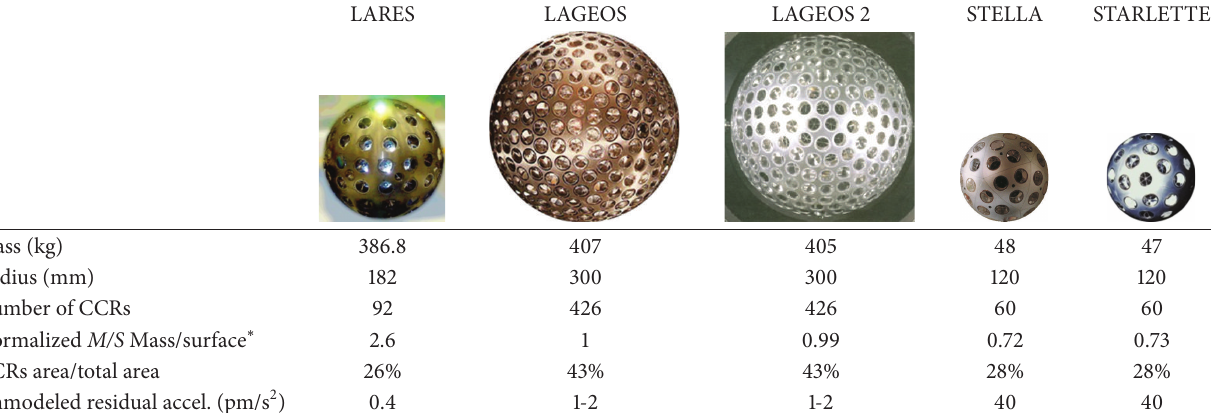
/( M/S ) , that is, the values of mass-to-surface ratio, are normalized with Satellite LAGEOS